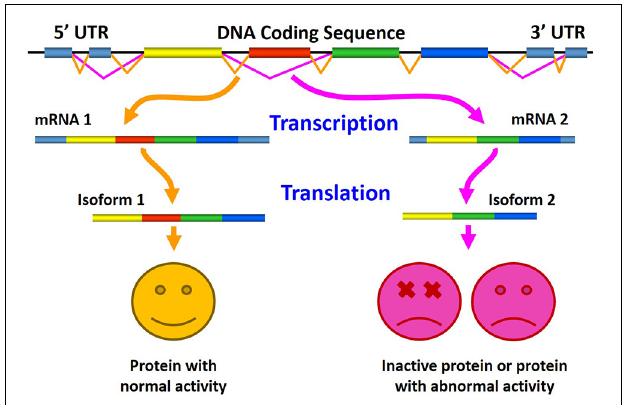
FIGURE 4 | Schematic representation of the role of aberrant alternative splicing in production of pathogenic proteins. Here, normal splicing results in the production of biologically active protein (left) , whereas altered alternative splicing generates either inactive protein or a splice variant with an abnormal (pathological) activity (right)